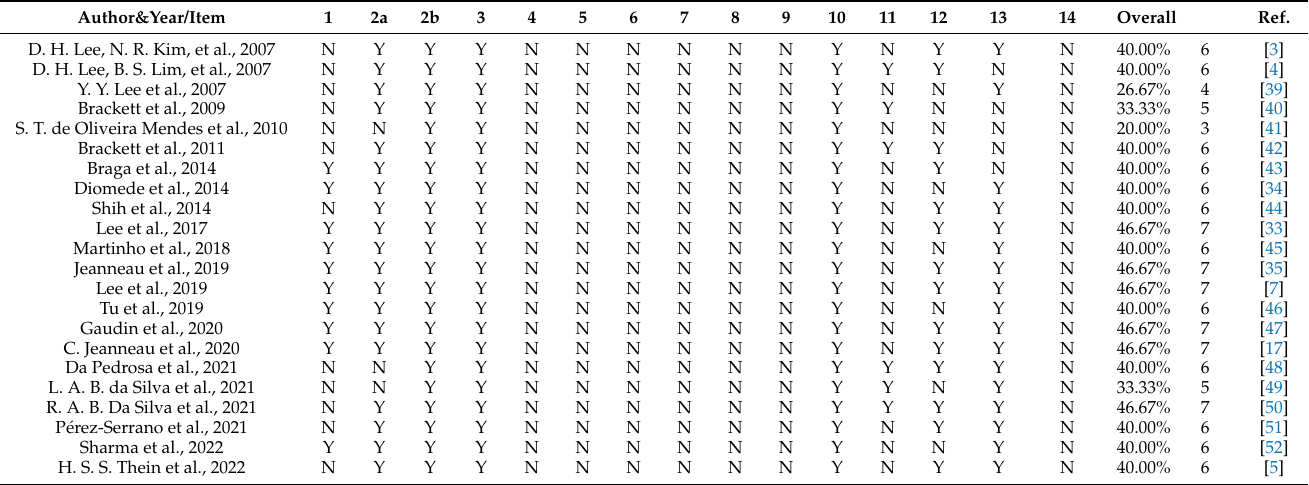
Table 3. Risk of bias of in vitro studies assessed by ‘Modified CONSORT checklist of items for reporting in vitro studies of dental